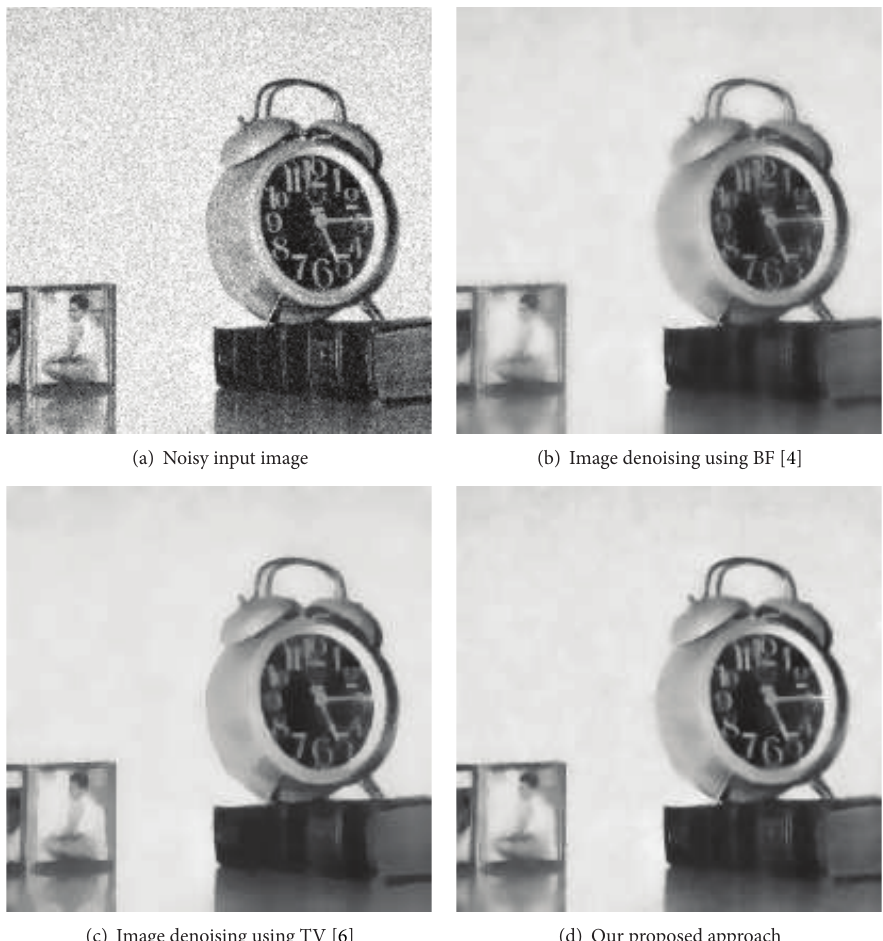
Figure 1: Comparison of image denoising between previous approaches and our proposed